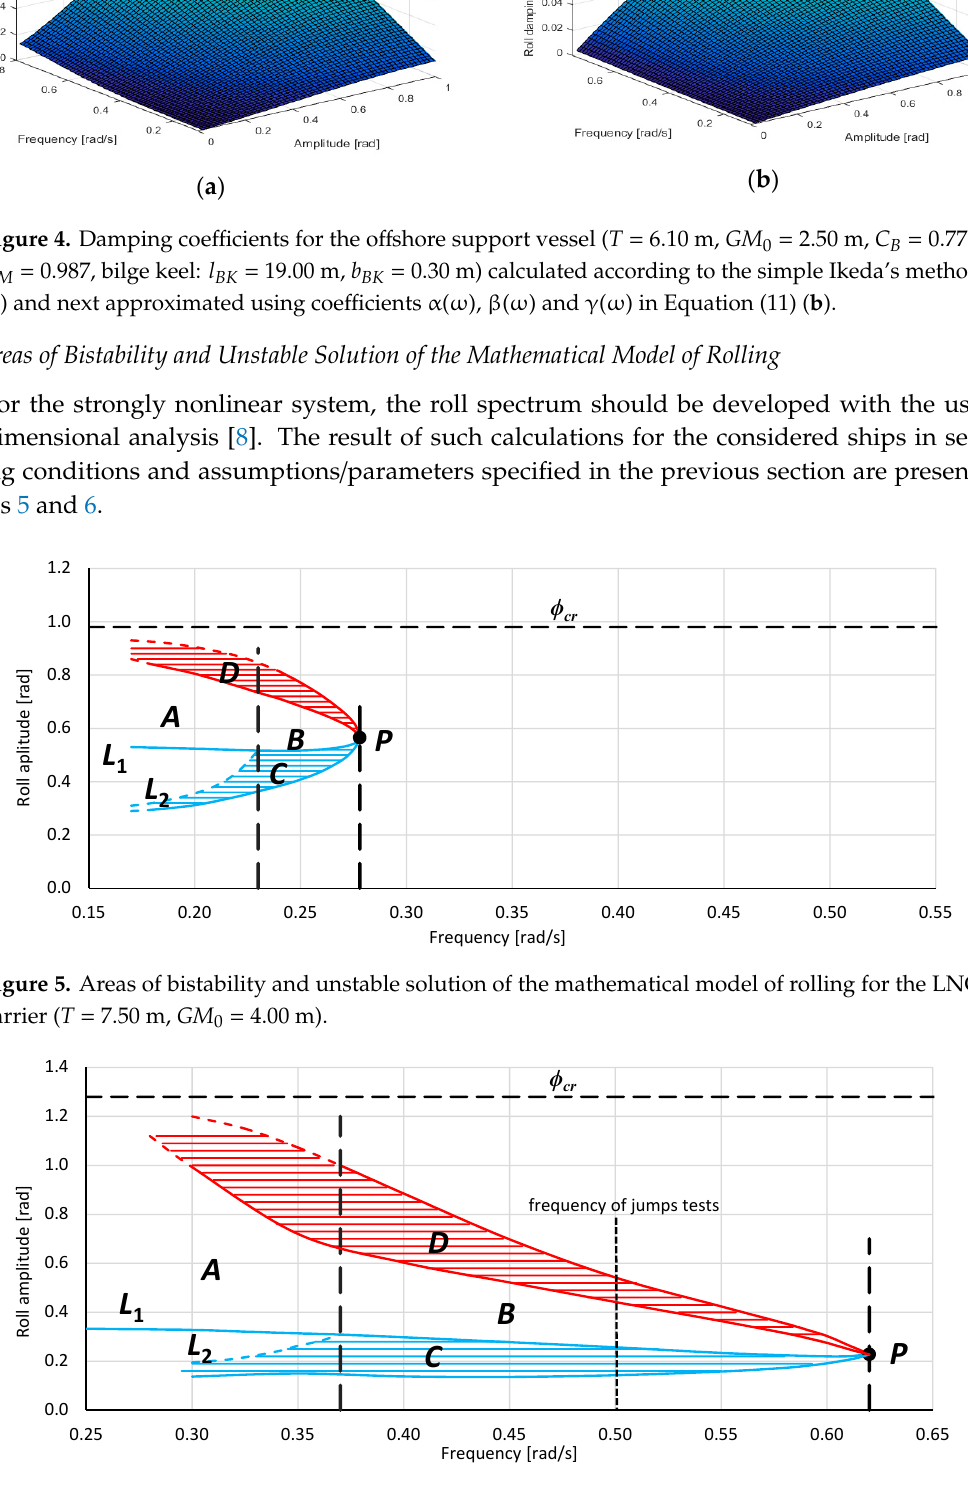
Figure 3. Damping coefficients for the LNG carrier ( T = 7.50 m, GM 0 = 4.00 m, C B = 0.813, C M = 0.972, bilge keel: l BK = 40.00 m ≈ 0.15 L PP , b BK = 0.50 m) calculated according to the simple Ikeda’s method ( a ) and next approximated using coefficients α ( ω ), β ( ω ) and γ ( ω ) in Equation (11) ( b ).